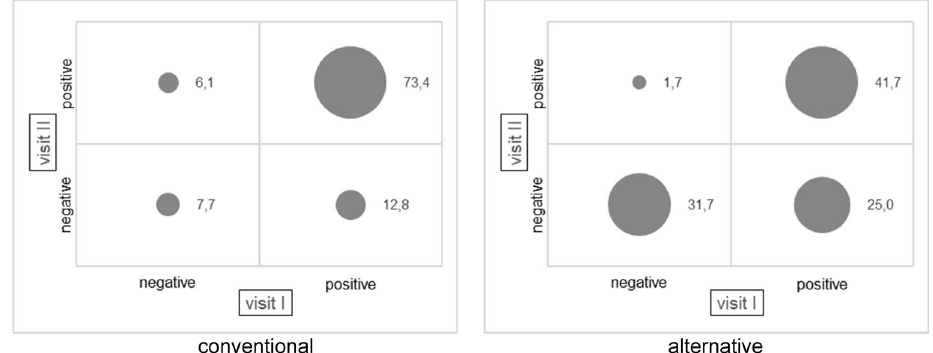
Figure 3. Categories of LA-MRSA-status of surfaces from beginning of fattening period (visit I) to end of fattening period (visit II) (percentages)—conventional (n = 2*312 = 624) and alternative (n = 2*60 = 120) housing systems.